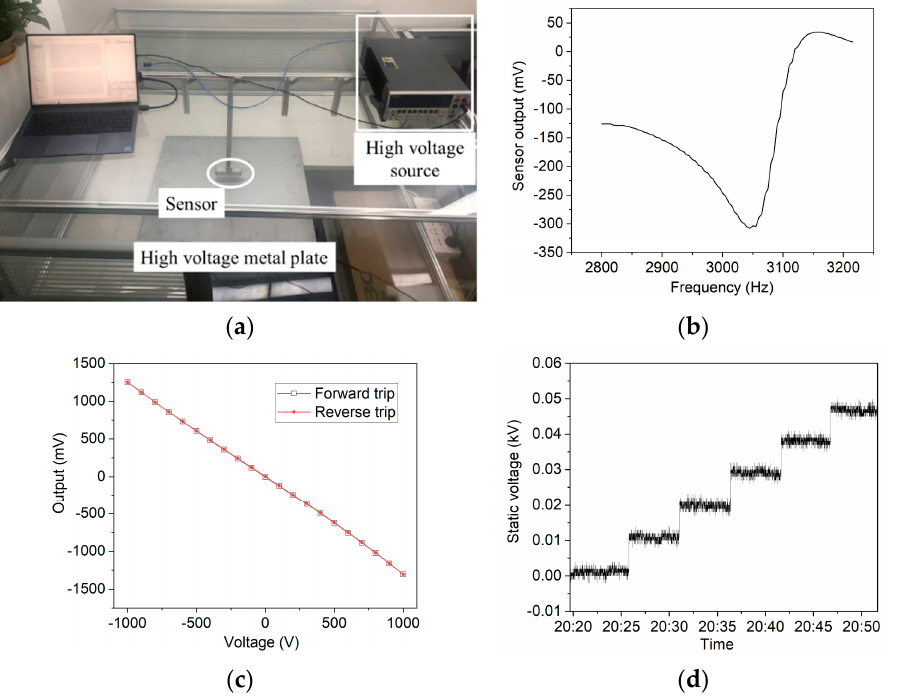
Figure 4. The electrostatic voltage calibration system and results of the sensor. ( a ) Picture of the calibration system, including the high-voltage source, the metal plate of 0.6 m × 0.6 m, the sensor’s metal support, and the computer. ( b ) The amplitude-frequency characteristic of the resonant microchip. The frequency ranged from 2800 Hz to 3200 Hz, and the resonant frequency shown by the curve was 3045 Hz. ( c ) Calibration results of the meter prototype above the charged metal plate. The voltage generated by the Keithley 2410 changed from − 1 kV to 1 kV and then changed backwards to examine the hysteresis of the prototype. ( d ) Long-term accuracy measurement results after calibration. Six voltages, equally ranging from 0 V to 50 V, were applied on the metal plate, and in each voltage five minutes’ results were recorded. The distance between the meter and the plate was 2 cm.